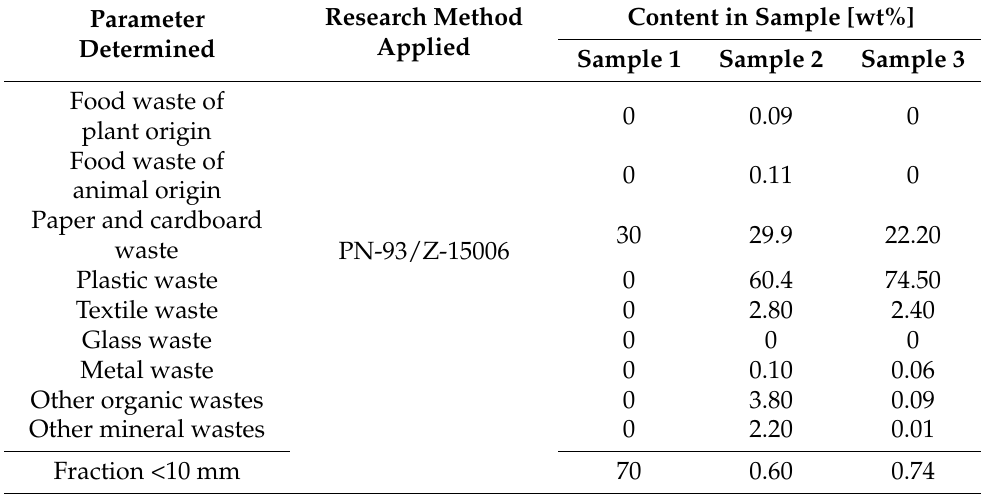
Table 3. Characteristics of post-sorting